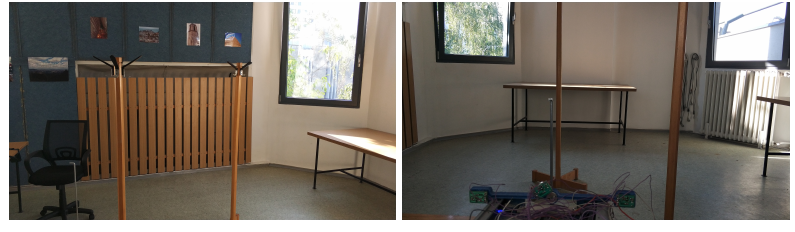
Figure 16. Indoor test No.